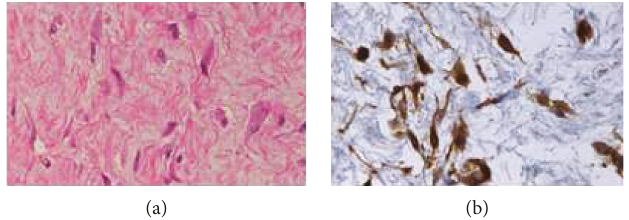
Figure 6: (a) Specimen (HE staining): spindle-shaped or star-shaped tumor cells proliferate di ff usely with abundant collagen fi ber. (b) Specimen (beta-catenin staining): beta-catenin was positive in the tumor cell